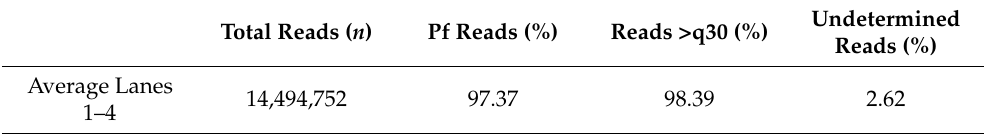
Table 1. Sequencing outcomes for RNA-Seq procedure.